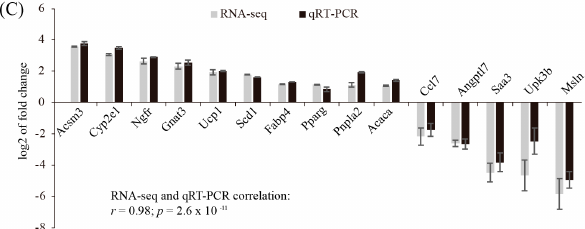
Figure 1. Identification of gene expression changes in the aorta of ApoE null mice fed a high-fat diet. ( A ) Volcano plot for the comparison between aorta samples from normal diet and high-fat diet fed ApoE null mice. The cutoff values for fold change and adjusted p -value were 2 and 0.05, respectively. Non-changed genes were shown in blue color. Red color is indicative of upregulated genes and green is indicative of downregulated genes; ( B ) Distribution of fold change values among differentially expressed genes; ( C ) Validation of selected genes identified by RNA-Seq using qRT-PCR. Fold-change values determined by both RNA-seq and qRT-PCR were presented as the mean ± SD (standard deviation).